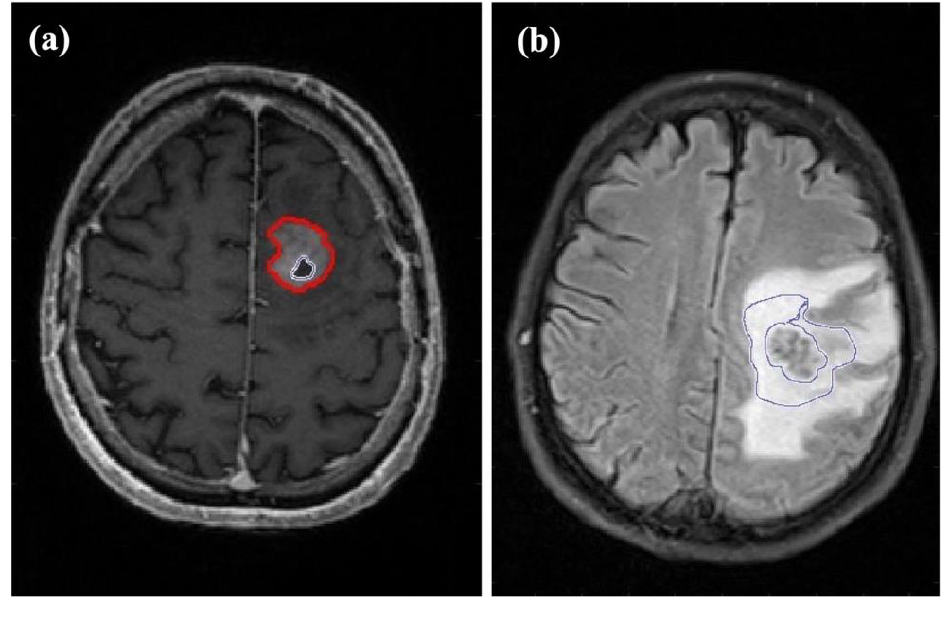
Figure 2. Examples of the different regions of interest (ROIs) assessed in this study. ( a ) Axial T1- weighted contrast-enhanced image of a 71-year-old male patient with glioblastoma in the frontal lobe of the left hemisphere. The outer ROI marks contrast-enhancing tumor while the ROI inside the tumor indicates the central necrosis. ( b ) Axial FLAIR image of a 66-year-old male patient with a left hemispheric metastasis in the perirolandic region from unknown primary. The ROI marks the proximal edema bordering the solid-appearing tumor.